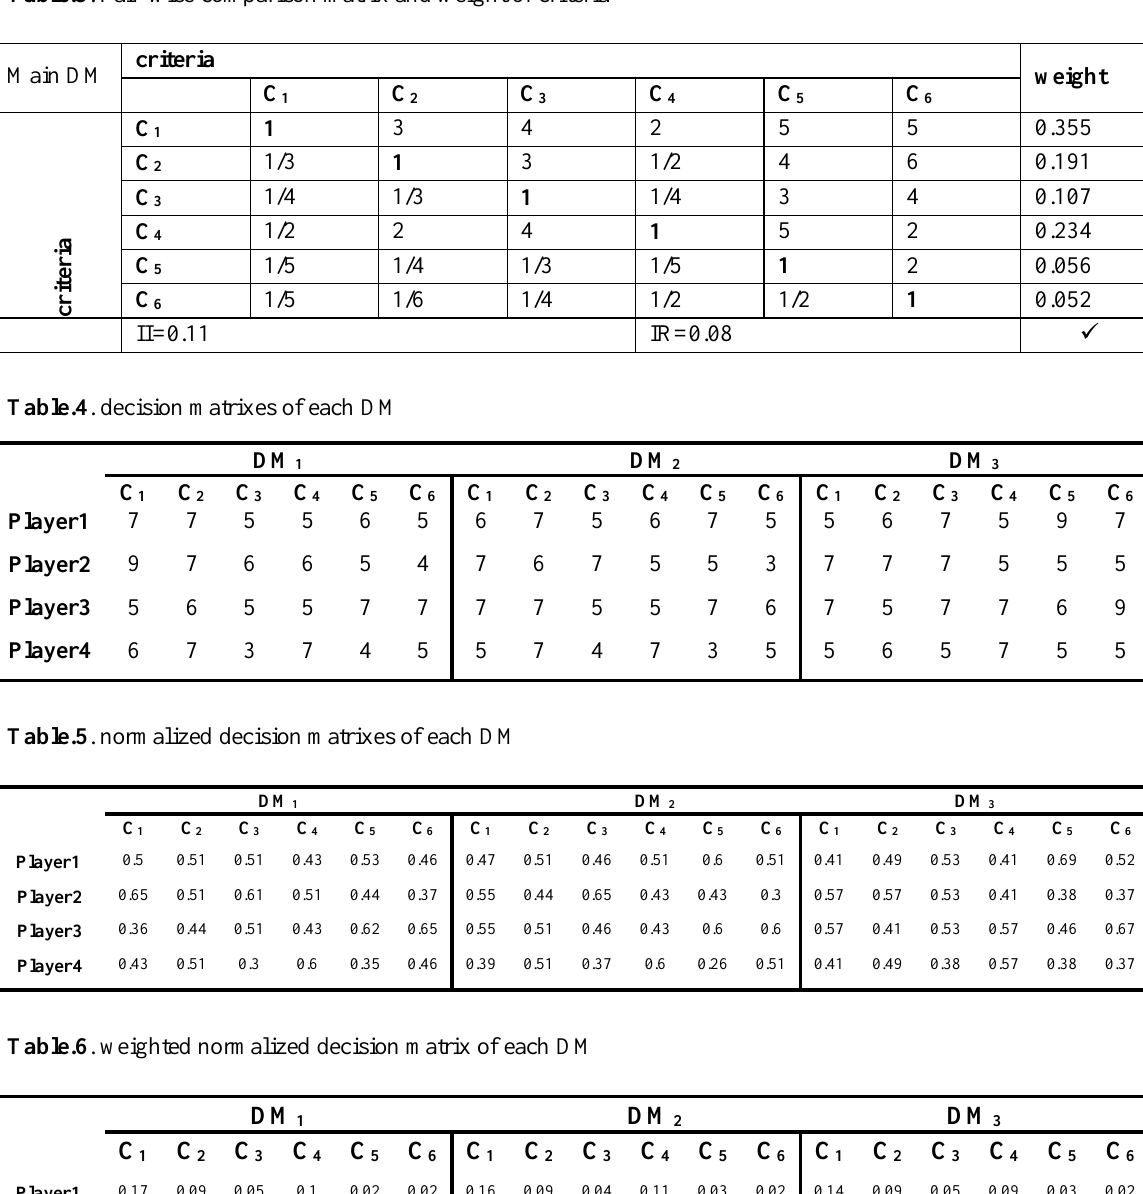
Table.3 . Pair-wise comparison matrix and weight of criteria